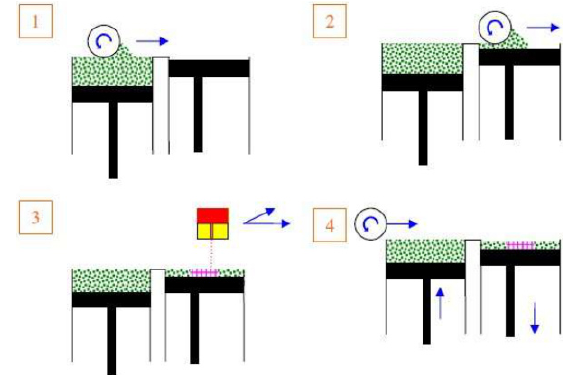
Figure 7. Procedures of 3D printing. A thin powder layer is rolled onto a platform (steps 1 and 2); Inkjet printer dispense binder onto this thin powder layer selectively (step 3); The roller placed a new thin powder layer onto the platform then repeat step 3 (step 4). After repeating these steps for a period of time, a 3D structure can be obtained [51].